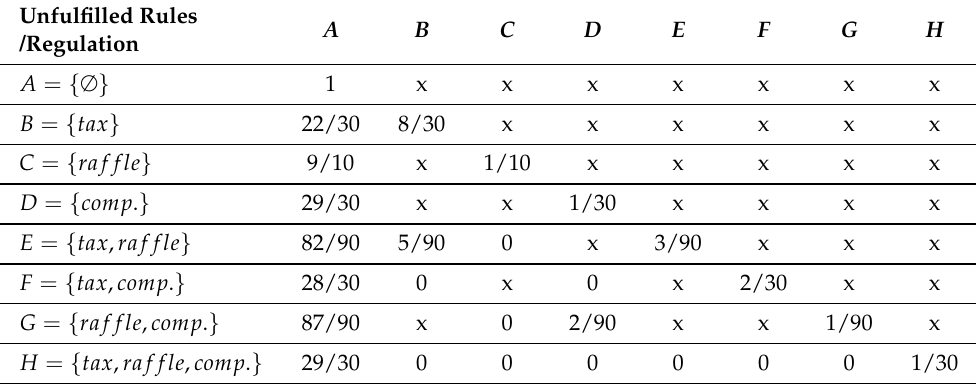
Table 1. Probability of breaching each rule (or set of rules) under each regulation.